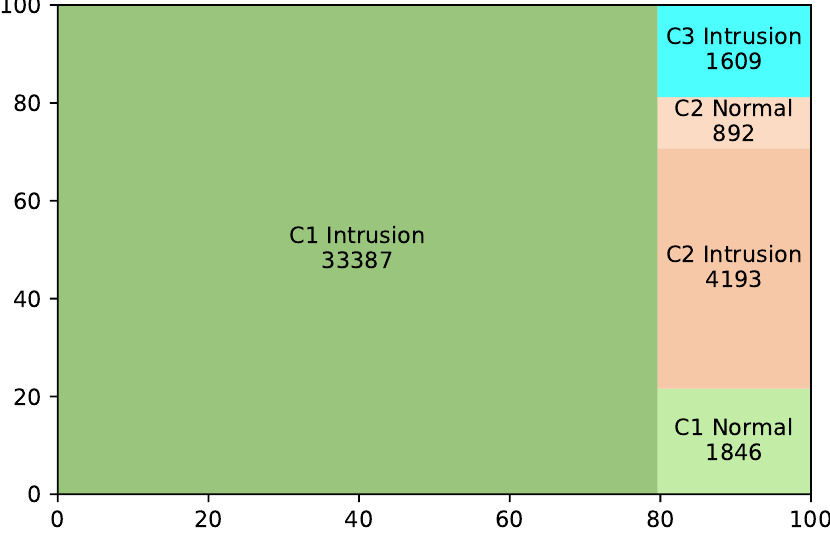
Figure 7. Distribution of instances after